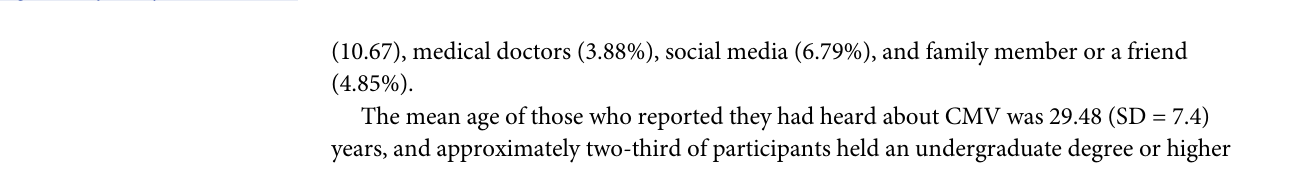
The mean age of those who reported they had heard about CMV was 29.48 (SD = 7.4) years, and approximately two-third of participants held an undergraduate degree or higher